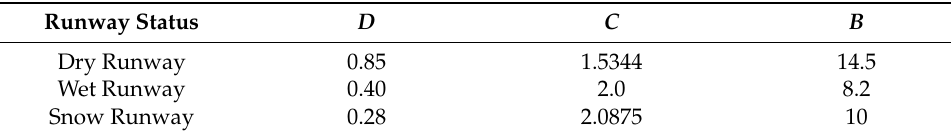
Table 5. Parameters of combination coefficient model.